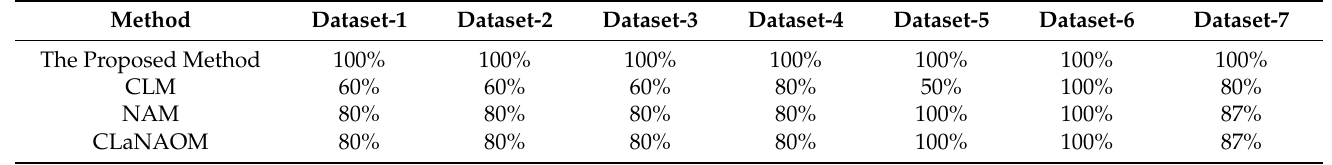
Table 26. The accuracy rate for each method using in the first to seventh dataset to extract the mountain